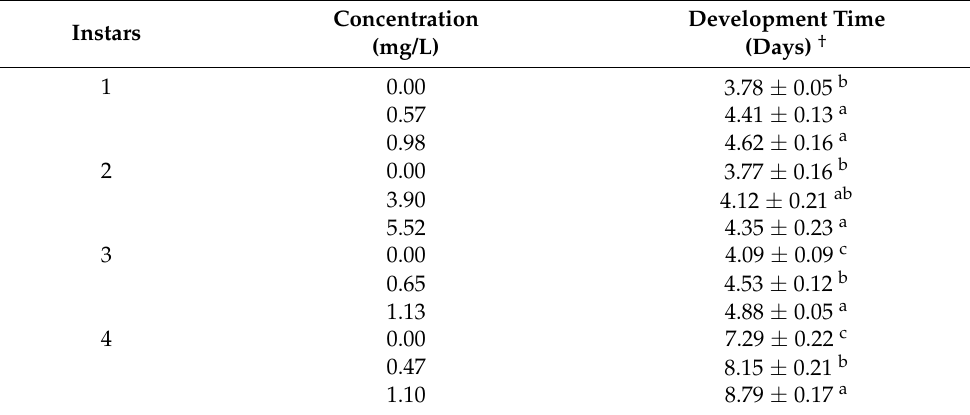
Table 3. Effects of sublethal concentrations of Kathon on larval development duration of C. quinque- fasciatus .